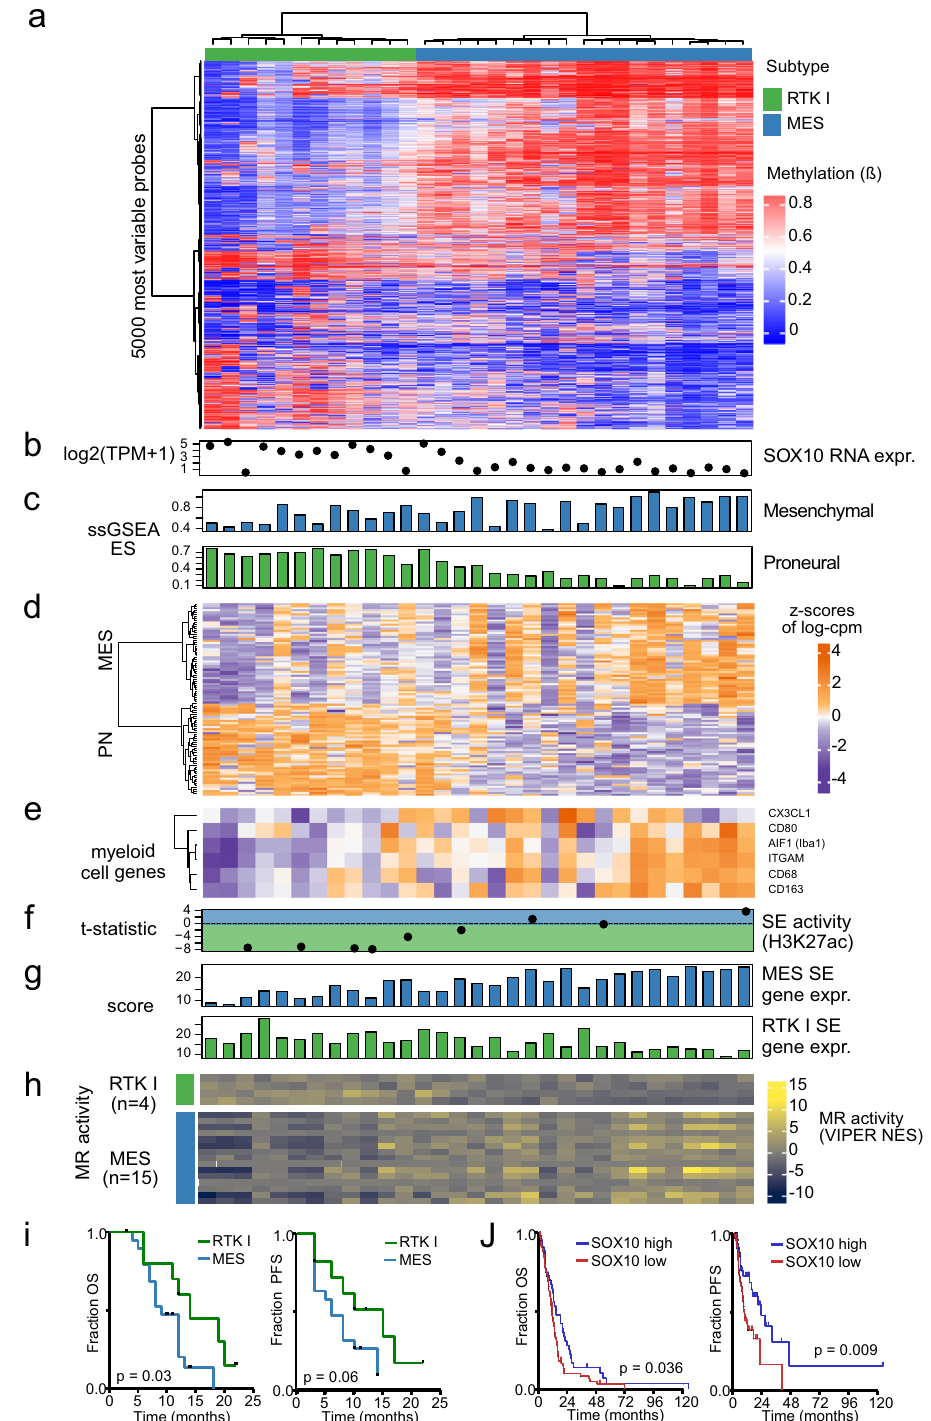
Fig. 7 Genetic and epigenetic patterns of RTK I-to-MES transition in primary glioblastoma tissues. a Clustering of the 5000 most variable microarray probes in RTK I and MES tumours ( n = 31) from our cohort identi fi ed 3 clusters consisting of RTK I tumours, MES tumours with intermediate genotypes and MES tumours with typical MES genotypes. b SOX10 RNA-seq (log 2 TPM + 1) expression. c Wang PN and MES subtype signature ssGSEA score. d Relative expression of Wang PN and MES subtype marker genes. e Relative expression of myeloid cell marker genes. f RTK I and MES SEs differential H3K27ac enrichment ( t -statistic) R. g Expression score of each subtype-speci fi c SE ’ s target genes (MES: n = 422; RTK I: n = 279). h MR activity (VIPER NES) of the RTK I ( n = 4) and MES CRC MRs ( n = 12). i Kaplan-Meier survival curves for the RTK I and MES subgroups, considering overall (left panel; P = 0.030) and progression-free survival (right panel; P = 0.060). j Kaplan-Meier survival curves for MES tumours ( n = 132) of the TCGA glioblastoma cohort strati fi ed by average SOX10 expression. Overall survival (left panel; P = 0.036); progression-free survival, (right panel; P = 0.009). Group cut-off: average expression; statistical signi fi cance was determined by two-sided log-rank